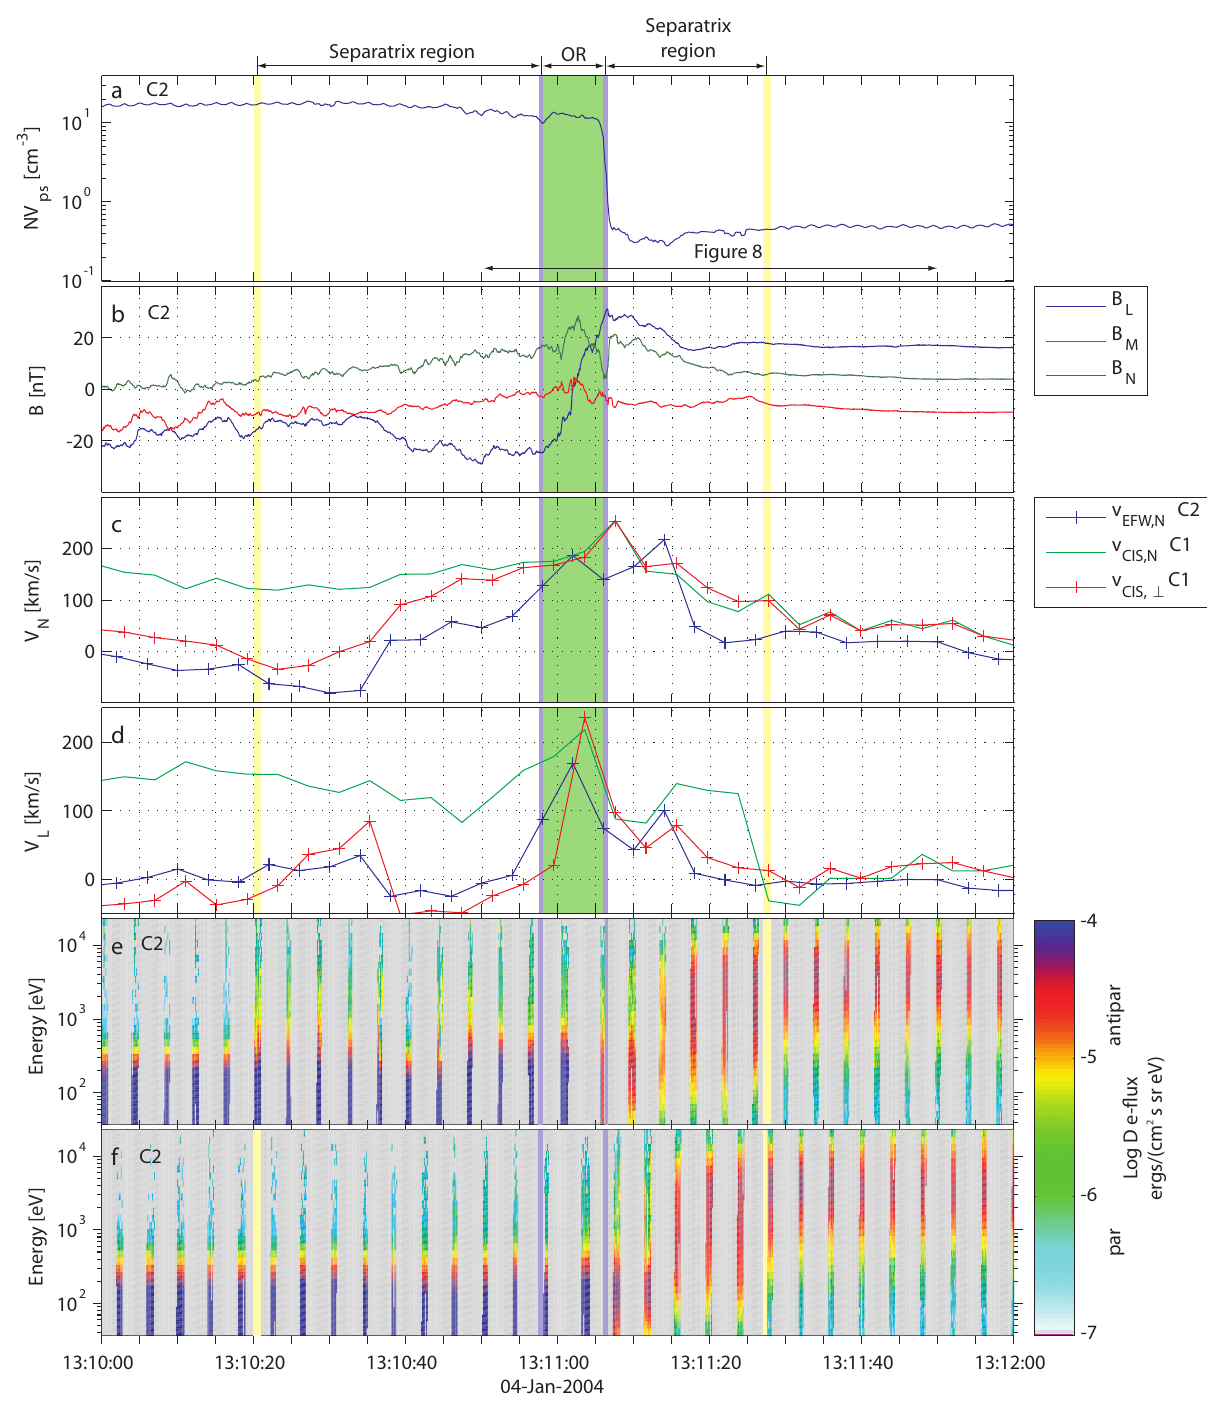
Fig. 7. Cluster crossing of the magnetopause reconnection layer on 4 January 2004, 13:11UT. The panels from top to bottom show: (a) plasma density, (b) LMN -components of the magnetic field, (c) v N normal plasma flow velocity, (d) v L flow velocity components of plasma flow velocity (full and perpendicular), (e) electron flux anti-parallel to B and (f) electron flux parallel to B . The LMN -directions are: L =[ − 0.73 − 0.45 0.53], M =[0.69 − 0.48 0.55], N =[0.01 0.76 0.65] in GSE. The velocity of the magnetopause is v dis =210[ − 0.02 0.74 0.67]km / s GSE. Vertical green bar marks the outflow/field reversal region (OR), and yellow bars mark the outer and inner separatrices. Arrow in the top panel marks the time interval presented in detail in Fig.